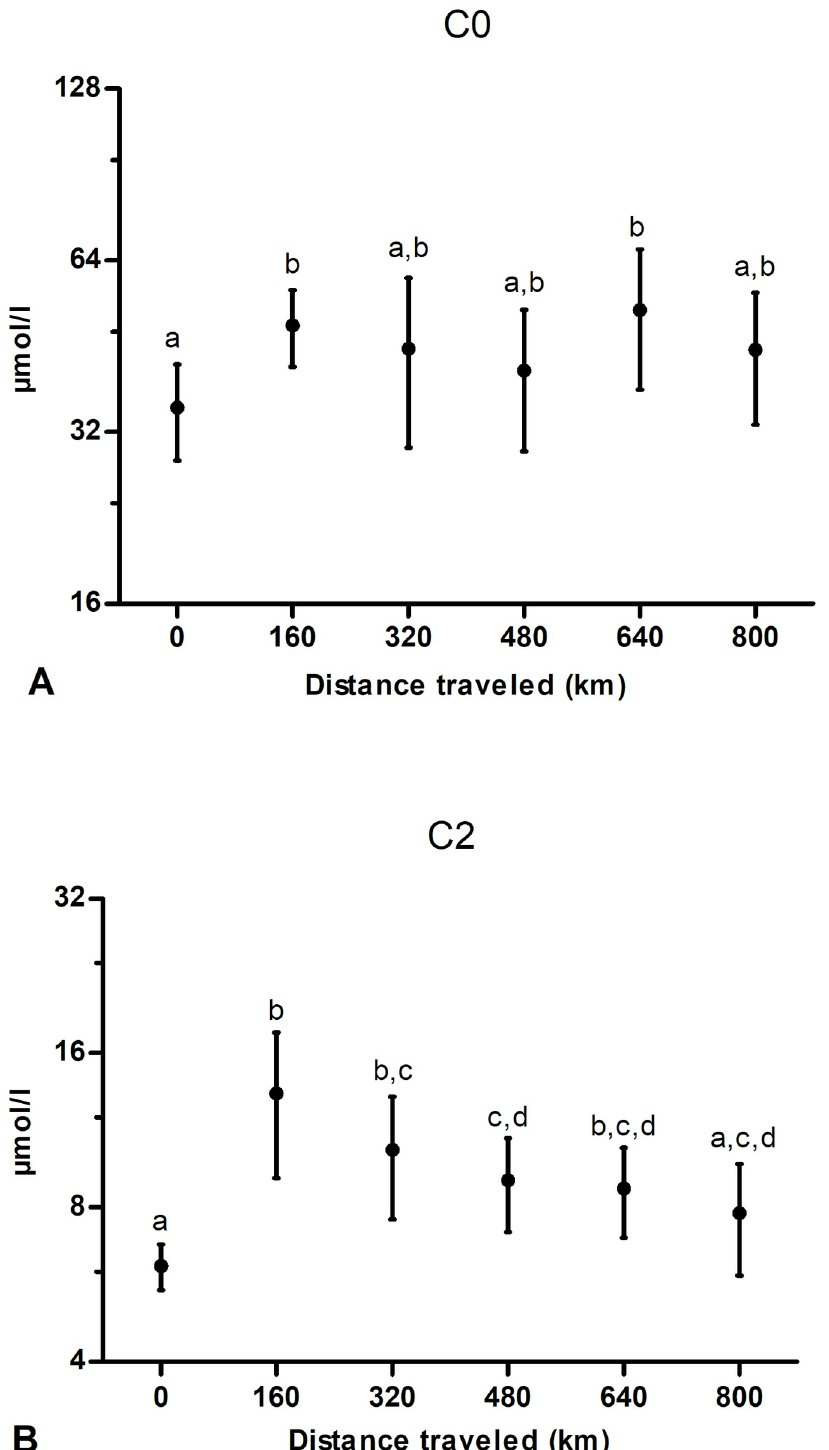
Fig 1. Effect of multiday exercise on plasma free carnitine, or C0 (A) and acetylcarnitine, or C2 (B). Samples were obtained from 9 dogs at 0, 160, 320, 480, 640 and 800 km. Data are displayed as raw data (mean ± SD) on a logarithmic axis. Columns with different superscripts (a, b, c, d) are significantly different between them ( P < 0.05) and not significantly different from columns with the same superscript.